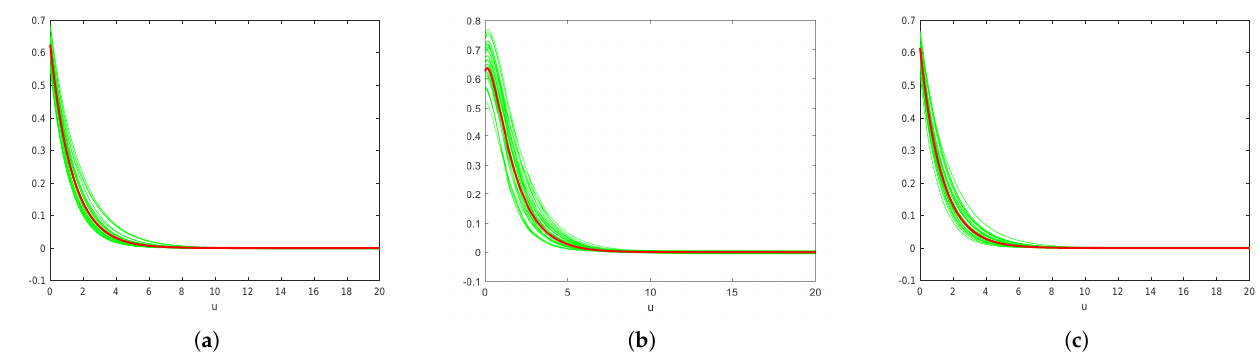
Figure 2. For the compound Poisson risk model, we estimate the Gerber–Shiu functions by true value curves (red curves) and 25 estimated value curves (green curves). ( a ) Ruin probability; ( b ) Expected claim size causing ruin; ( c ) Laplace transform of ruin time.